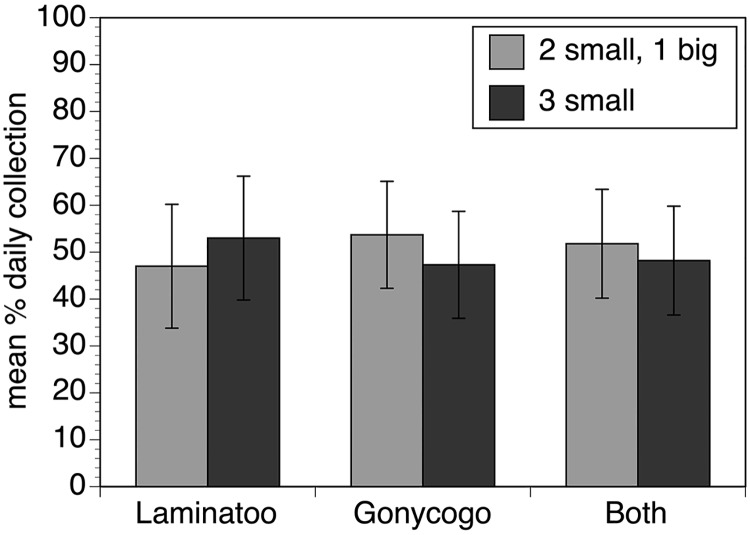
Relative performance of three trap batteries containing three 1m square traps versus two 1m square traps flanking a 1.5m square trap.Bars represent the relative performance of the different trap combinations in Laminatoo, Gonycogo and data from both communities combined. Data are presented as the mean percentage of the total collection by day, normalizing for variations in the absolute number of flies collected on each day, as described in Materials and Methods. Error bars indicate the standard deviation associated with the means. The analysis from Laminatoo incorporated data collected from 18 paired trials, while the analysis from Gonycogo included data collected from 24 paired trials. Raw collection data for this study may be found in the S2 Table.